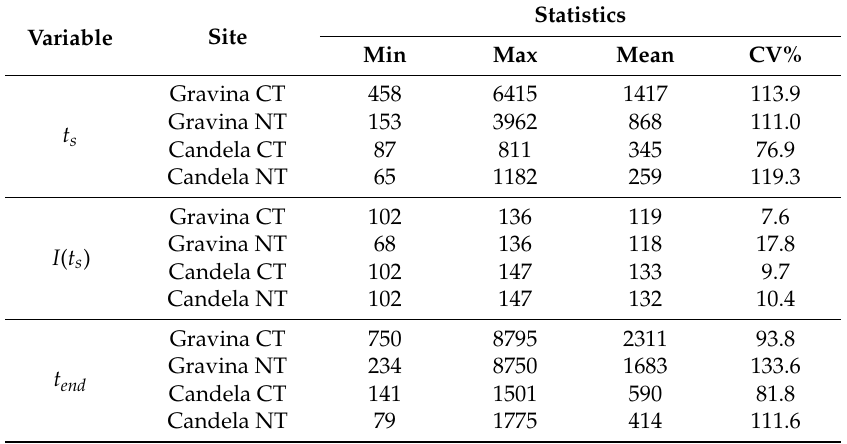
Table 5. Minimum (Min), maximum (Max), mean, and coefficient of variation (CV%), of the equilibration time, t s (s), infiltrated depth at the equilibration time, I(t s ) (mm), and total duration, t end (s) for the infiltration runs.